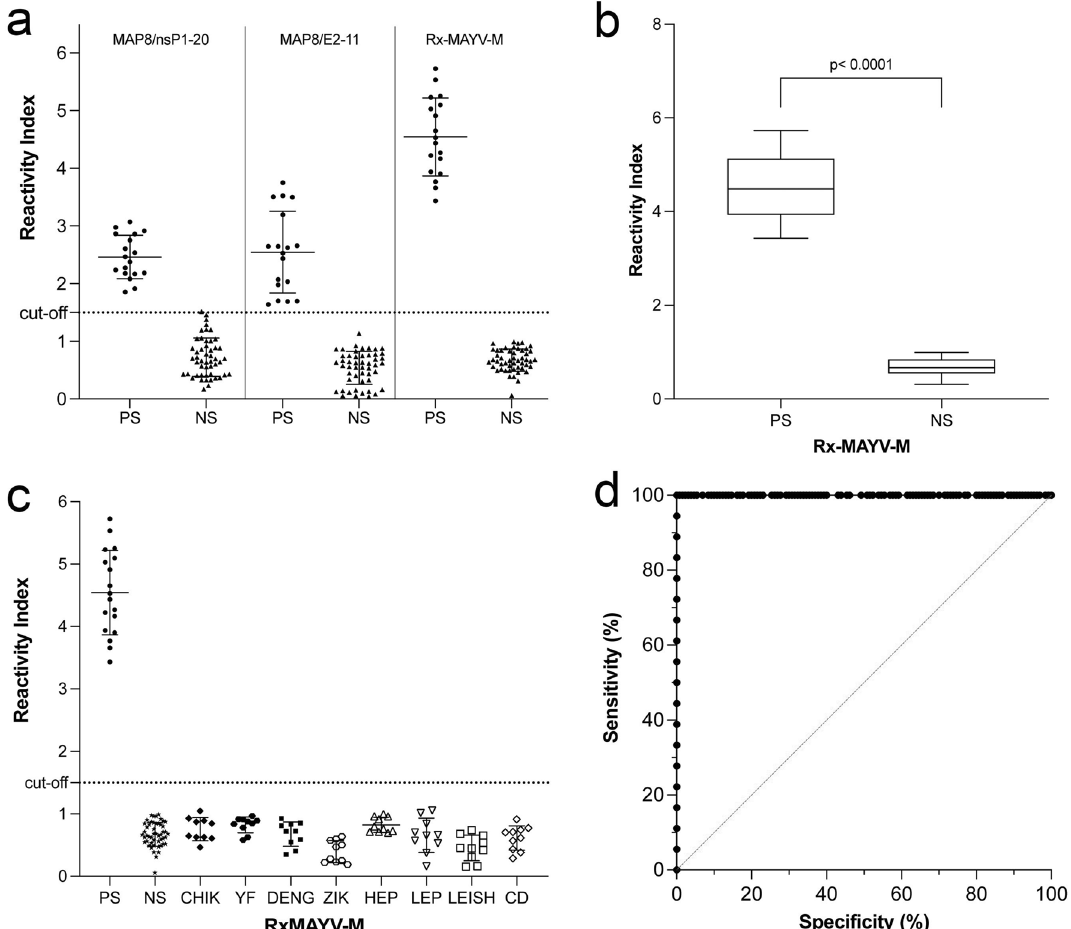
(YRTFGAERGGSRTLDSR), and the engineered Dx-MAYV-M. ( a ) Their reactivity index for each of 18 serum samples from Mayaro fever patients, 80 serum of other infectious diseases [CHIKV, YFV, ZIKV, HBV,